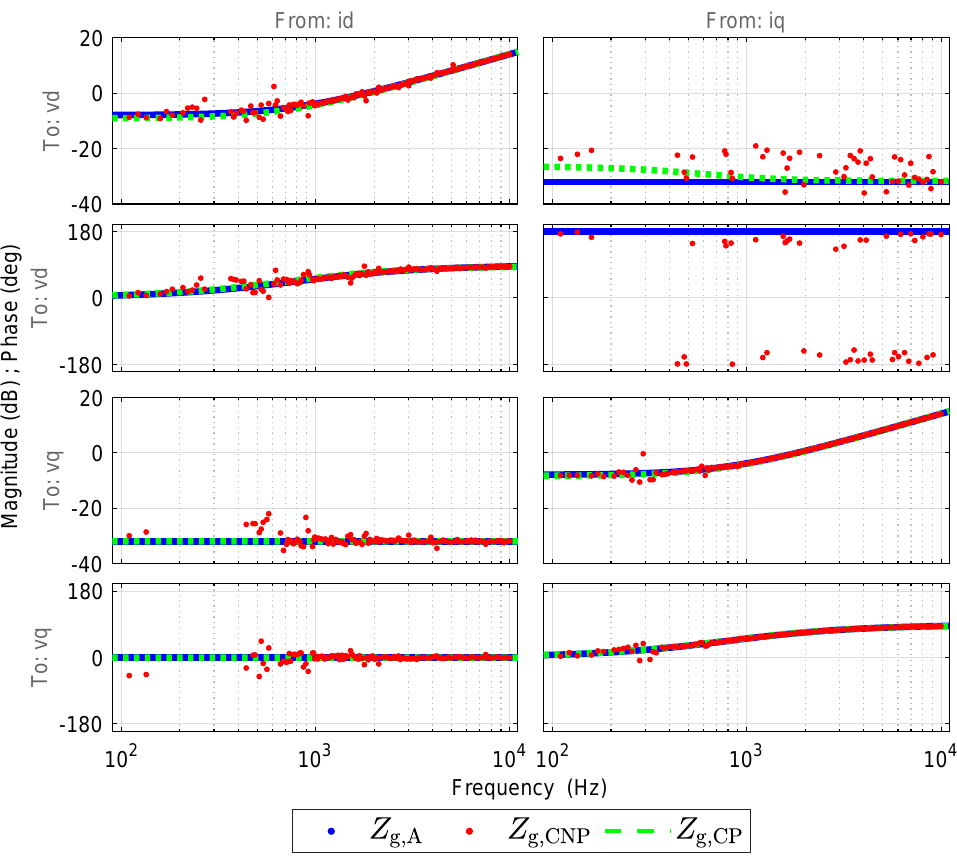
Figure 22. Identification of the parametric impedance based on compensated